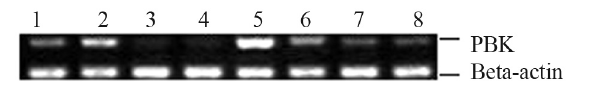
Figure 6 - Expression profile of the differentially expressed porcine PBK gene in tissue samples of an adult Meishan x Large White pig-cross. Lane 1, heart; 2, spleen; 3 small intestine; 4, fat; 5, muscle; 6, liver; 7, lung; 8,